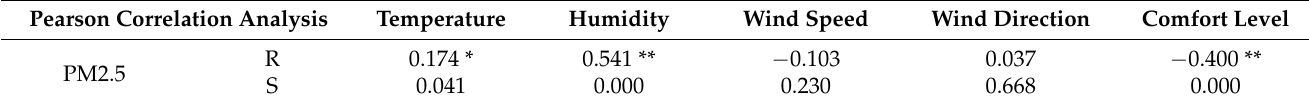
Table 5. Correlation table of PM2.5 concentration and meteorological